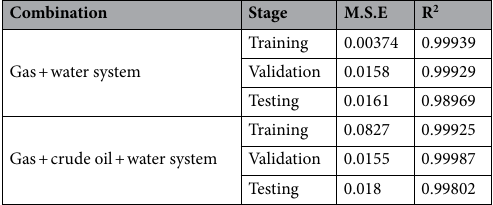
Table 1. M.S.E. and R 2 values recorded during ANN